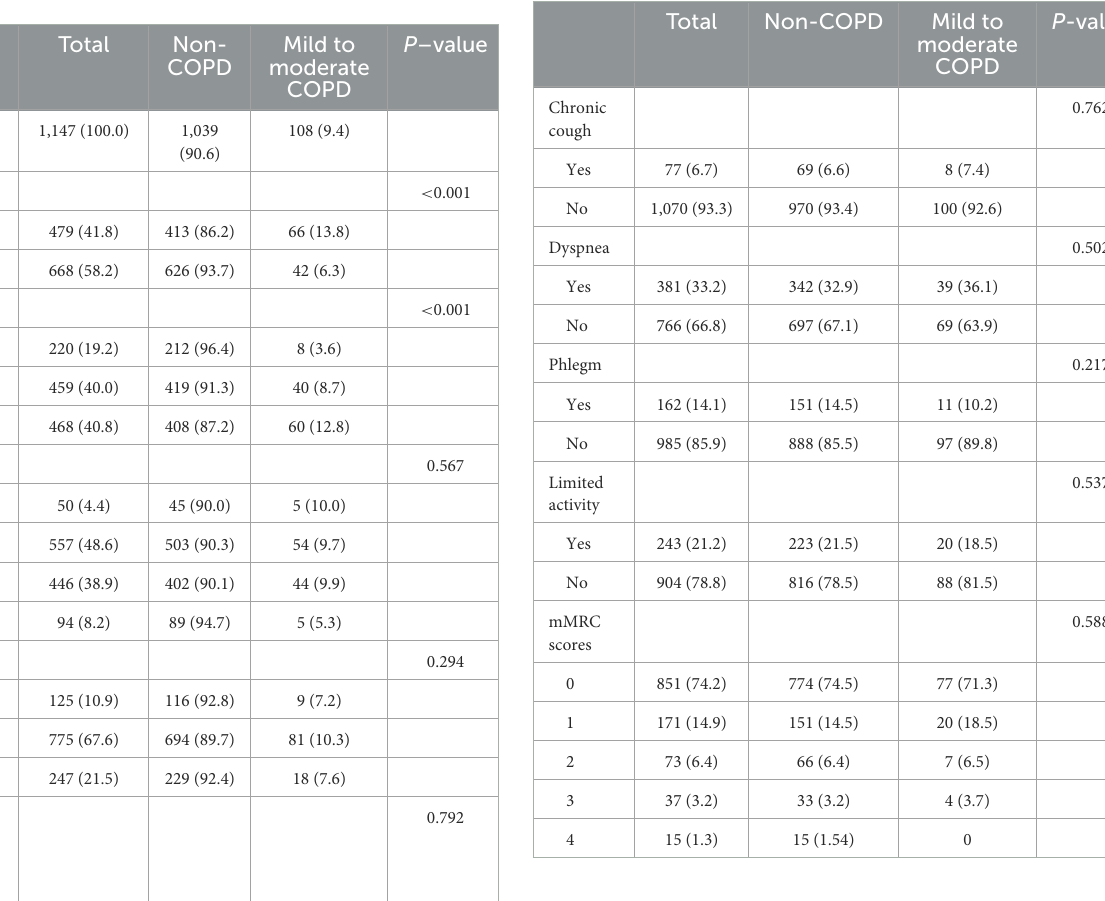
TABLE 2 Respiratory symptoms of 1,147